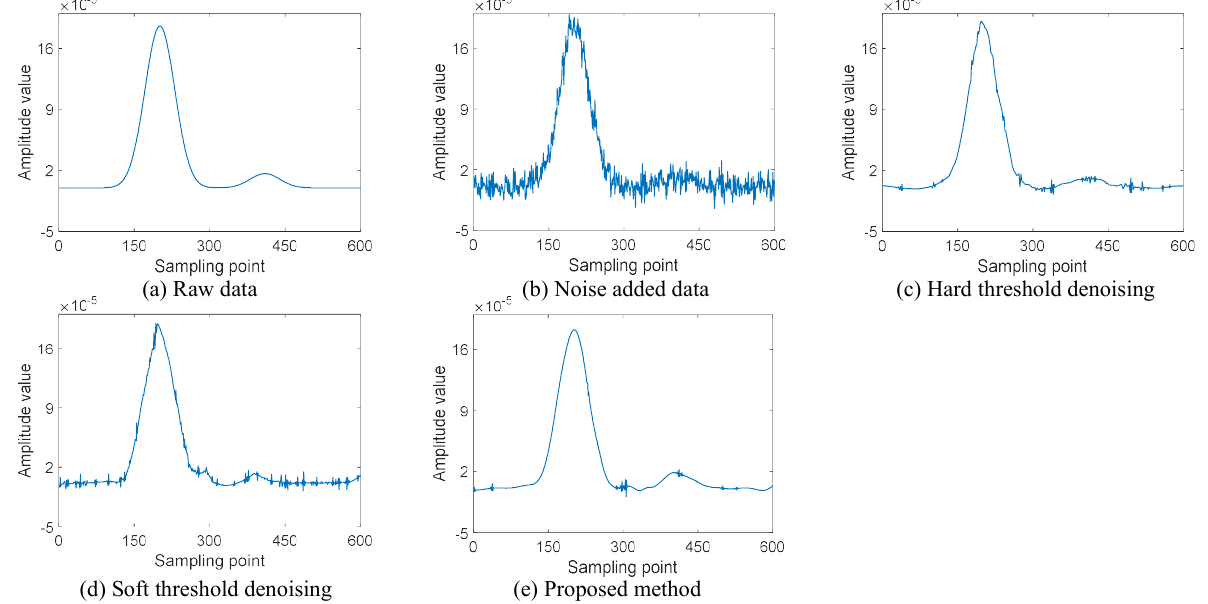
Figure 5. Comparison of three threshold functions for denoising the echo signals denoising